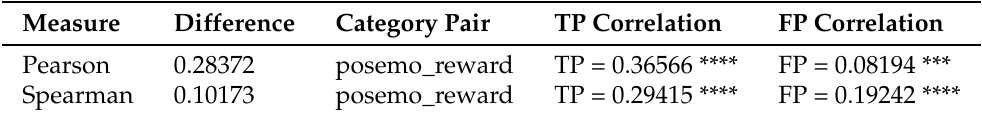
Table 8. Positive emotions and Rewards in Suicidal.